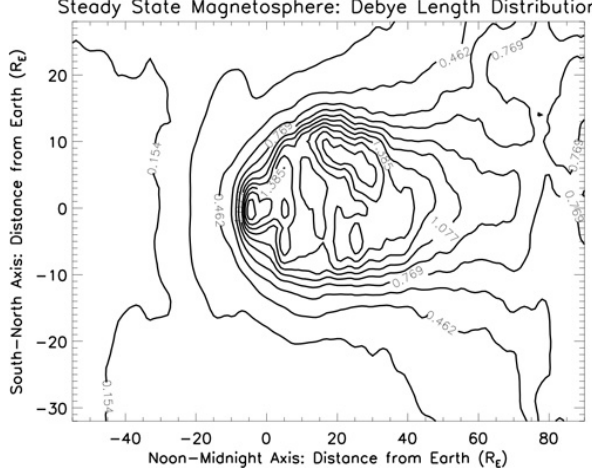
Fig. 1b. Debye length distribution in the same plane of density distribution shown in Fig. 1a. From magnetosheath to magnetotail, the Debye length in the magnetosphere is ∼ > 0.5, ensuring a kinetic description of the